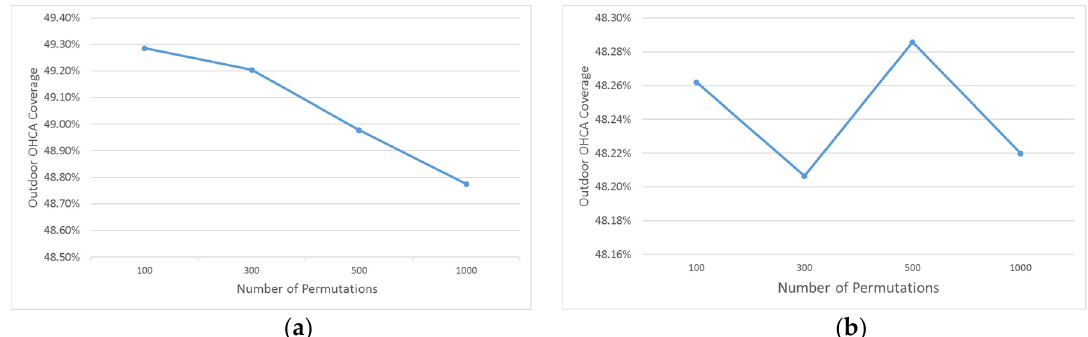
Figure 14. Coverage ratio in terms of the number of permutations for outdoor OHCA cases. ( a ) Grid-based coverage. ( b ) Network junction-based coverage.